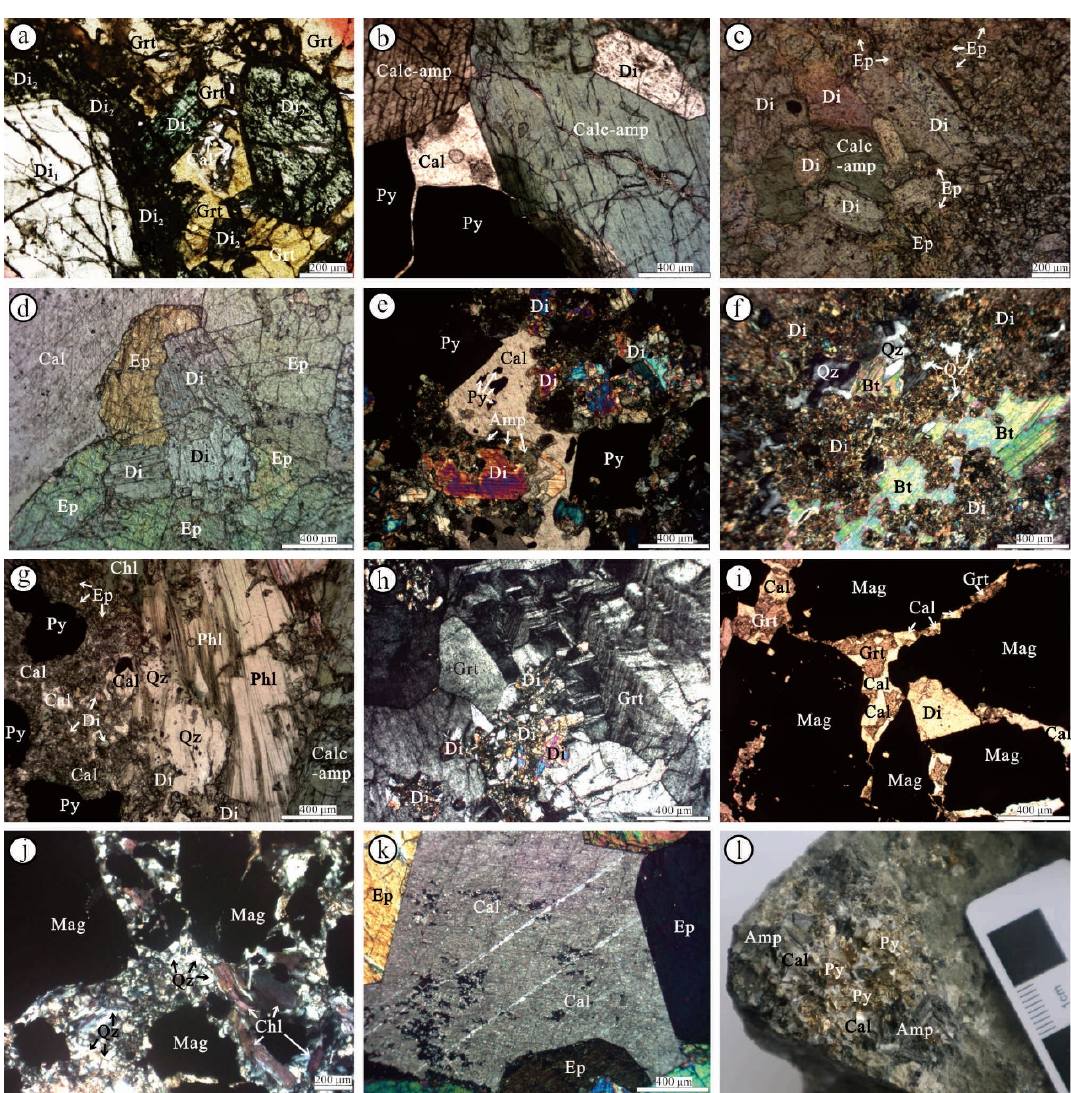
Figure 7. Paragenetic association of minerals from the different stages of mineralization. ( a ) Two types of euhedral diopside formed during the prograde skarn stage. Light-green diopside, which coexisted with garnet, grew along the margins of the colorless diopside. ( b ) Subhedral–euhedral Ca-rich amphibole that formed during the retrograde skarn stage. The amphibole replaced the early diopside and was partially replaced by late pyrite and calcite. ( c , d ) Diopside was replaced by late amphibole and epidote. ( e ) Early diopside was replaced by late amphibole, both of which were subsequently partially replaced by late pyrite and calcite. ( f ) Anhedral diopside was metasomatized and partially replaced by biotite and quartz. ( g ) Epidote, phlogopite, chlorite, calcite, and quartz have partially replaced early diopside. Note the association of phlogopite with Ca-rich amphibole. ( h ) Diopside was replaced by zoned andradite. ( i ) Massive magnetite was partially replaced by calcite that was modified by earlier diopside and garnet. ( j ) Massive magnetite was partially replaced by late anhedral quartz. ( k ) Euhedral epidote was partially replaced by late anhedral calcite, within which twin lamellae are parallel to the angle bisector of the two heterotropic cleavages. ( l ) Pyrite associated with calcite that partially replaced euhedral amphibole. Photos ( a – d , g , i ) were taken under open polarizer, and ( e , f , h , j , k ) were taken under crossed polarizers. in the figure caption. Abbreviations: Amp = amphibole, Bt = biotite, Calc-amp = calcic amphibole, Cal = calcite, Chl = chlorite, Di = diopside, Di1 = colourless diopside, Di2 = light green diopside, Ep = epidote, Grt = garnet, Mag = magnetite, Phl = phlogopite, Py = pyrite, Qz = quartz .